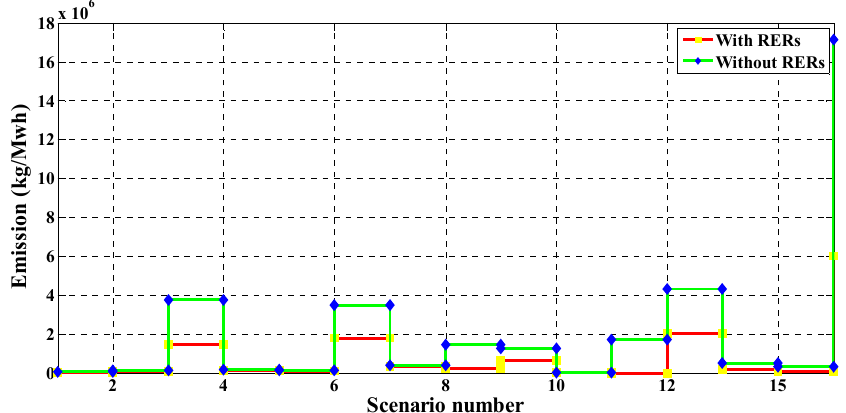
Figure 9. The IEEE 118-bus system emissions.